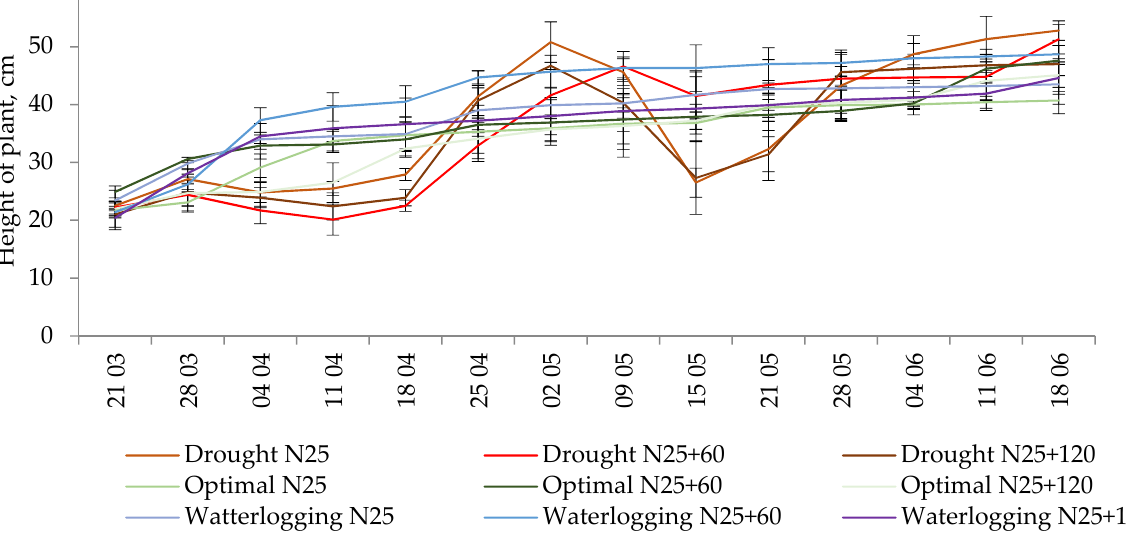
Figure 6. Assimilating leaf area of red clover and forage timothy. Note, differences between the means of treatments for separate plant species, marked by different letters (a, b, c), are significant ( p < 0.05). Whiskers indicate standard errors of the means. SM—soil moisture.